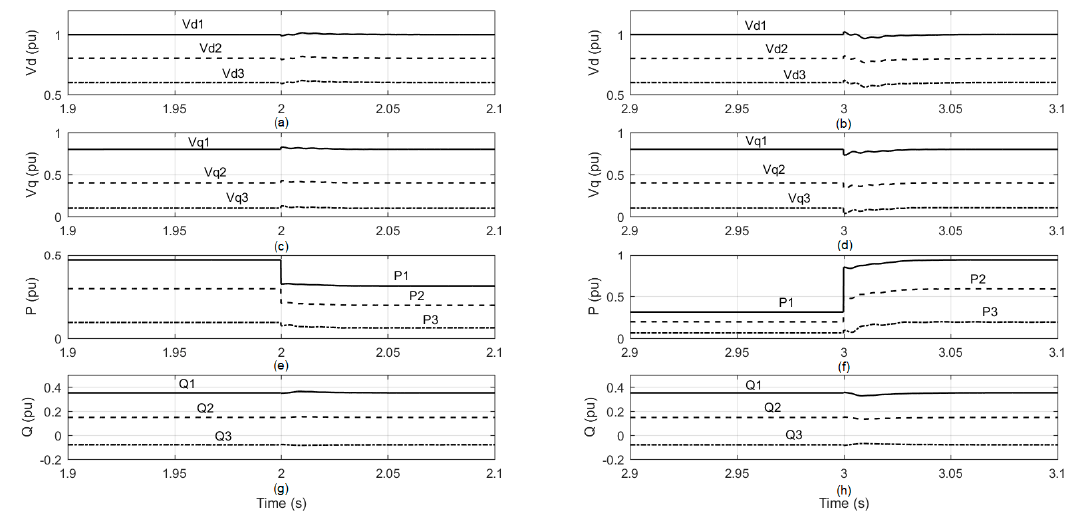
Figure 7. Dynamic performances of DG 1, DG2, and DG 3 as a result of step changes in the load resistance in three-phase system. ( a , b ) d-component of the load voltages at three DGs. ( c , d ) q-component of the load voltages at three DGs. ( e , f ) Output active power of three DGs. ( g , h ) Output reactive power of three DGs.